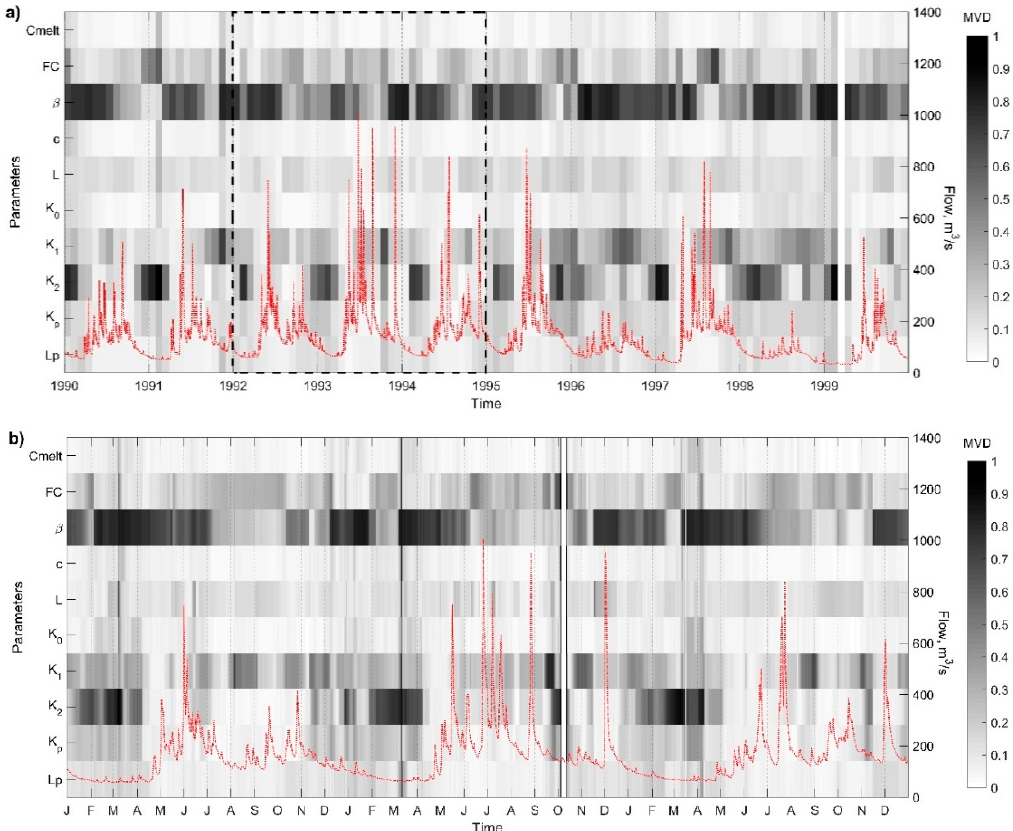
Figure 6. MVD calculated in windows of ( a ) 3 months (1990–1999) and ( b ) 31 days (1992–1994). The left vertical axis shows the parameters, the horizontal axis shows the time, and the right vertical axis shows the streamflow in m 3 / s. The dotted red line is the daily mean streamflow series (1990–1999). The MVD values are seen in grayscale. The white areas indicate that the index cannot be calculated.